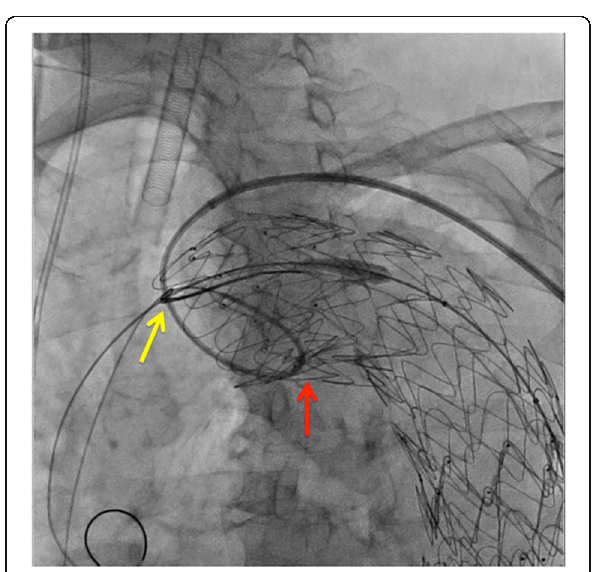
Fig. 3 Fluoroscopic image immediately after repair of the incomplete deployment of the SG using the double-snare technique. A catheter and GW are inserted through a guiding sheath and rotated under the stent-graft. The GW is passed through the loop (yellow arrow) of a snare, permitting deployment of the SG (red arrow)